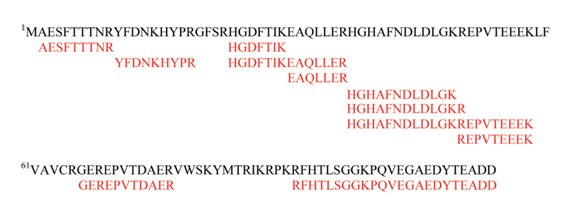
Validation of computationally predicted genes. Multiple peptides mapping to predicted gene ORF04105 evidence for the expression of the product(s) encoded by ORF04105. Protein sequence of ORF04105 shown in black, and the identified peptides are shown in red.